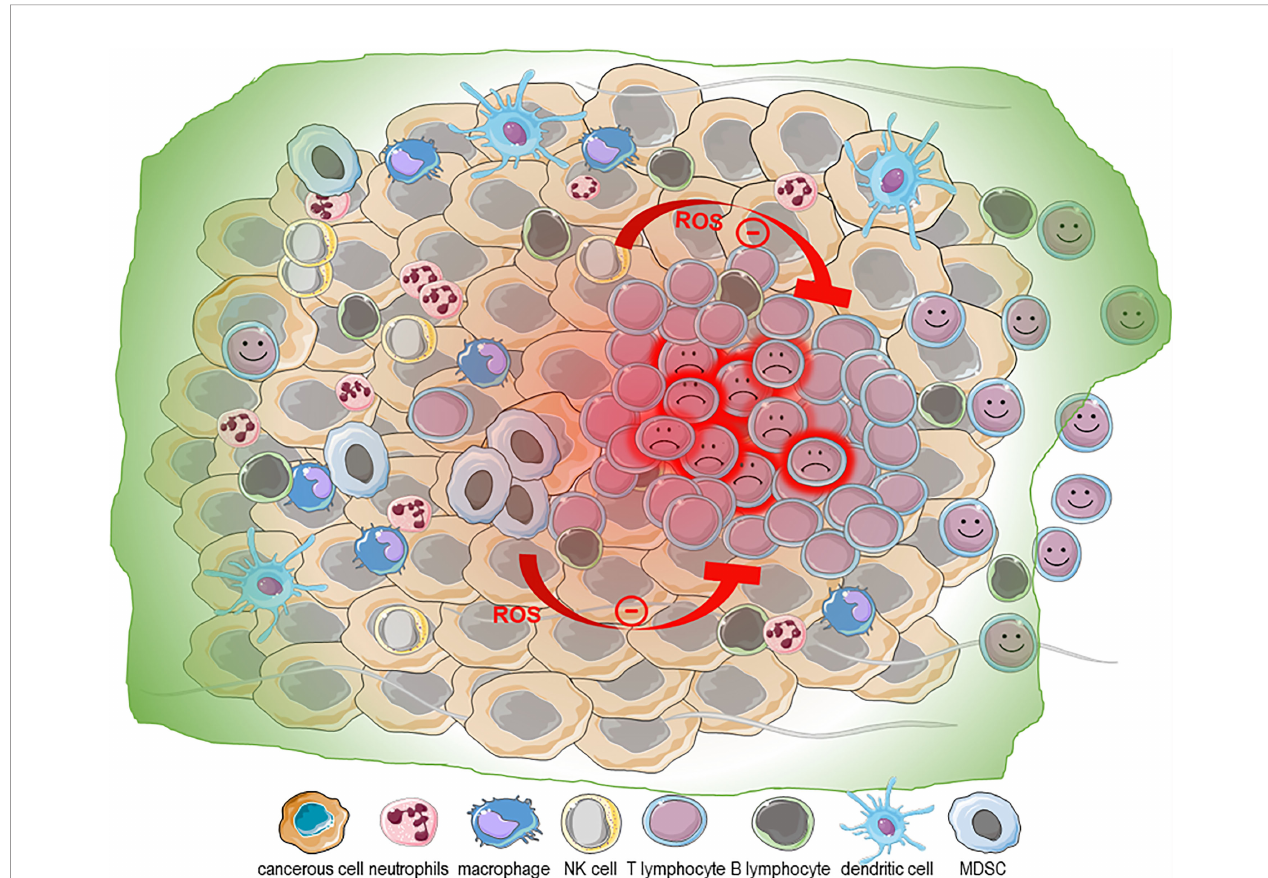
FIGURE 3 | ROS in the tumor microenvironment. The metabolic stress imposed by the neoplastic transformation and uncontrolled proliferation combined with the hypoxic nature and marked production of ROS contribute to the chronic in fl ammation state of the tumor microenvironment (TME). The oxidative nature of the TME is exacerbated by its in fi ltration with immune cells with altered phenotypes [neutrophils, macrophages and myeloid derived suppressor cells [MDSCs)]. NK cells and CD8+ effector memory T cells are particularly sensitive to even low doses of H 2 O 2 , while the T regulatory cells are protected from H 2 O 2 -dependent inhibition of their suppressive function and H 2 O 2 -induced death. Taken together, this supports that the oxidized TME may be a particularly inhospitable site for NK cells and CD8 T cells and detrimental to T cell-based adoptive cell transfer